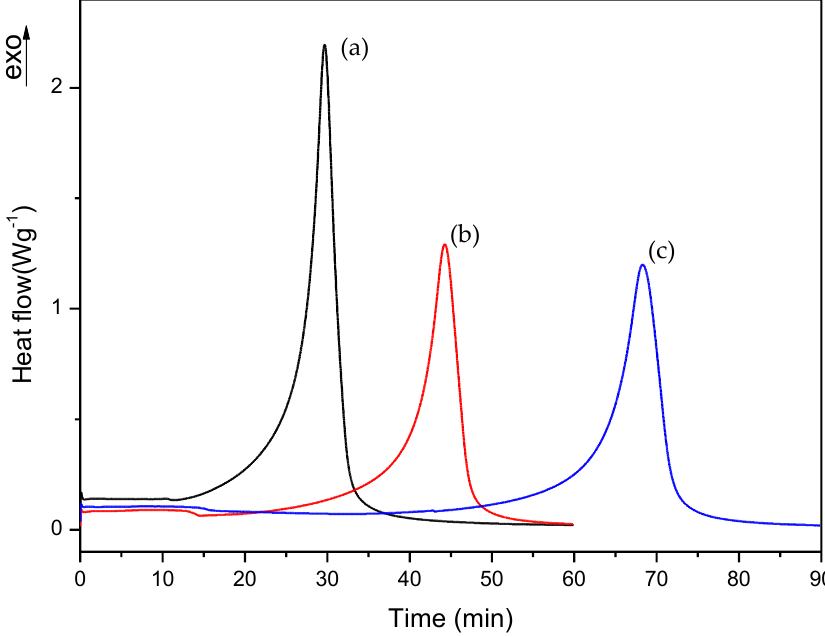
Figure 8. Isothermal DSC curves of (a) D, (b) E and (c) F formulations with 0.75% DMT.